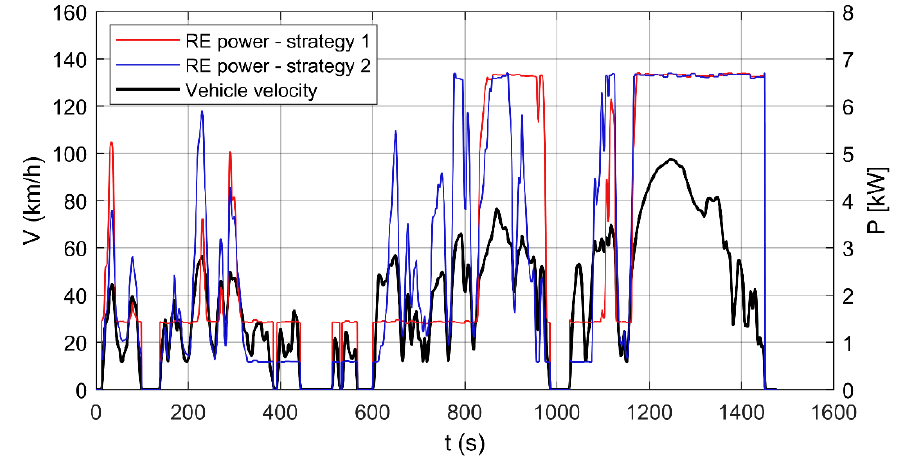
Figure 16. Range extender power for two control strategies along with vehicle velocity plot.